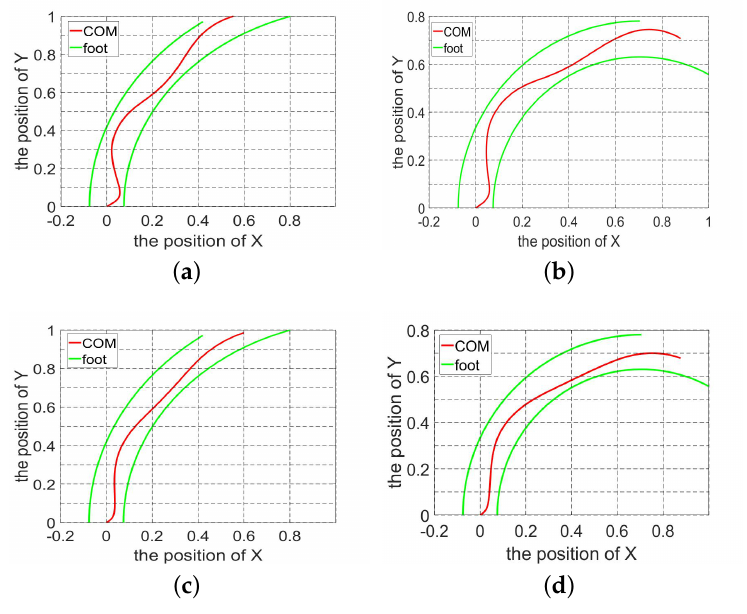
Figure 12. COM trajectories: ( a ) r c = 1.06 m, v ave = 1 km/h, ( b ) r c = 0.67 m, v ave = 1 km/h,